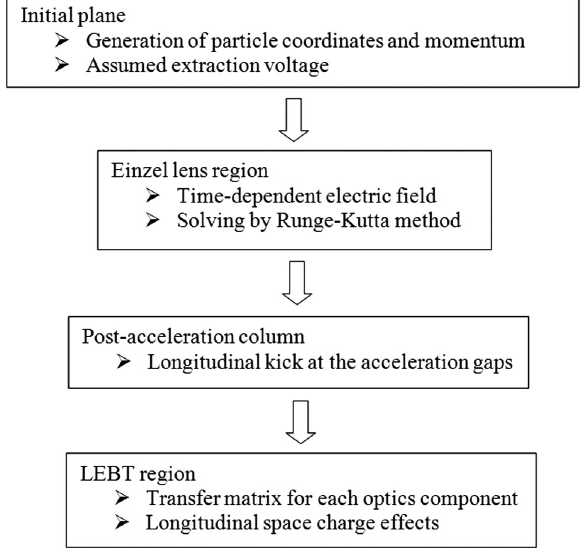
FIG. 25. Initial particle distribution and the corresponding Maxwell-Boltzmann distribution with T ¼ 5 eV